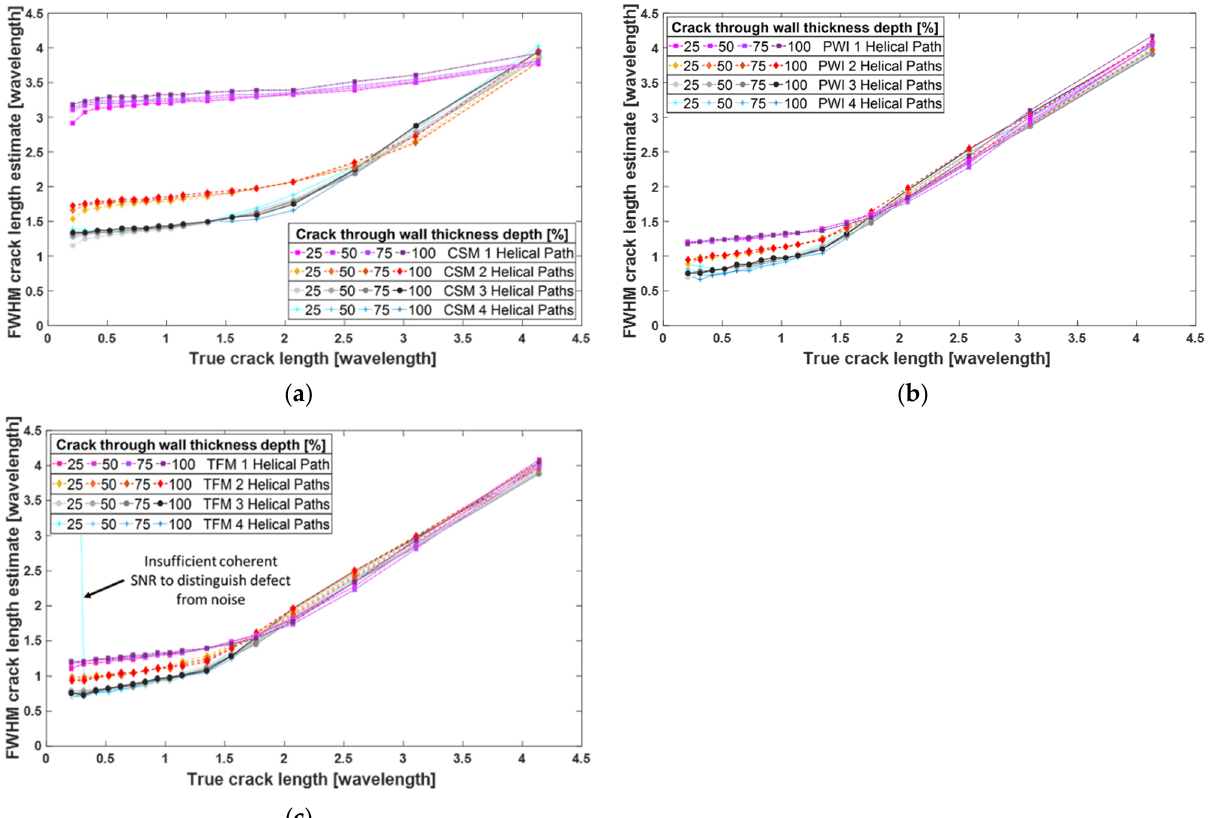
Figure A5. Crack length estimates obtained from ( a ) CSM, ( b ) PWI and ( c ) TFM reconstructed images from FE data, plotted against true crack lengths for different range of helical paths used for focusing on reception.